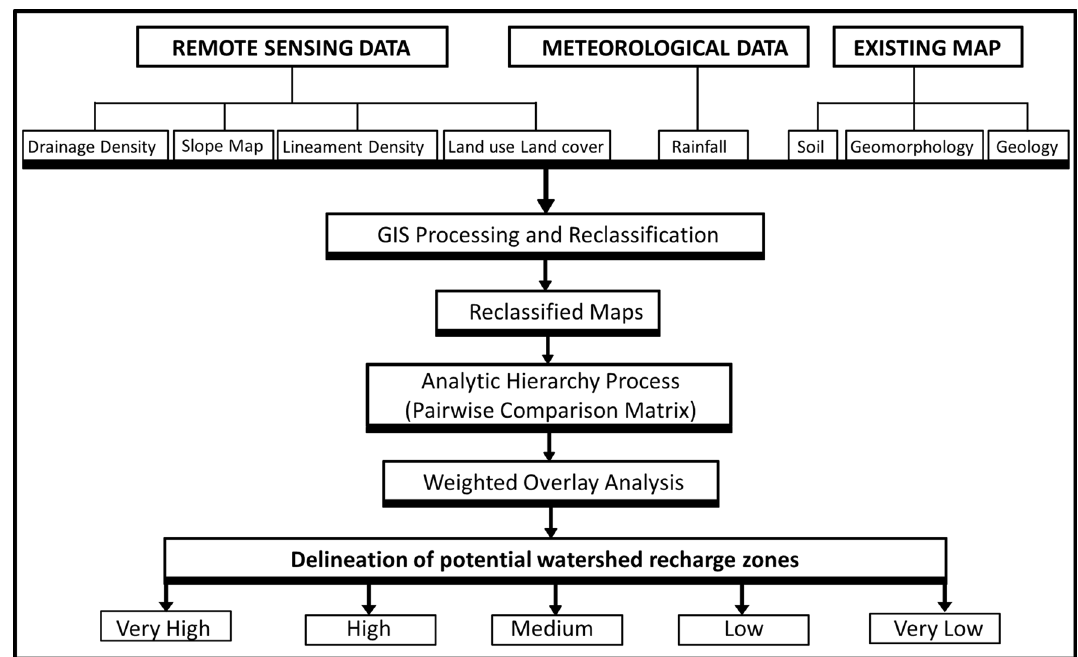
Fig. 2 Workflow diagram for the evaluation of potential groundwater recharge